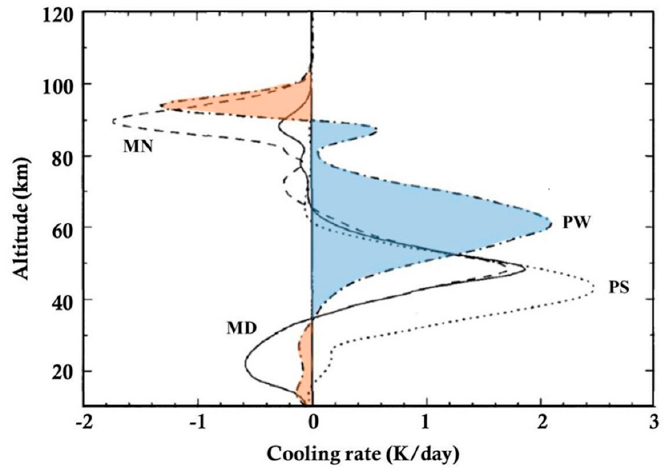
Figure 6. Cooling rates of ozone for non-local thermodynamic equilibrium (LTE) conditions caused by a radiative process are presented in the altitude region of 10–120 km for mid-latitude day (MD, solid) and night (MN, dashed) and for polar winter (PW, dot-dashed) and summer (PS, dotted). This figure is adopted from [43].